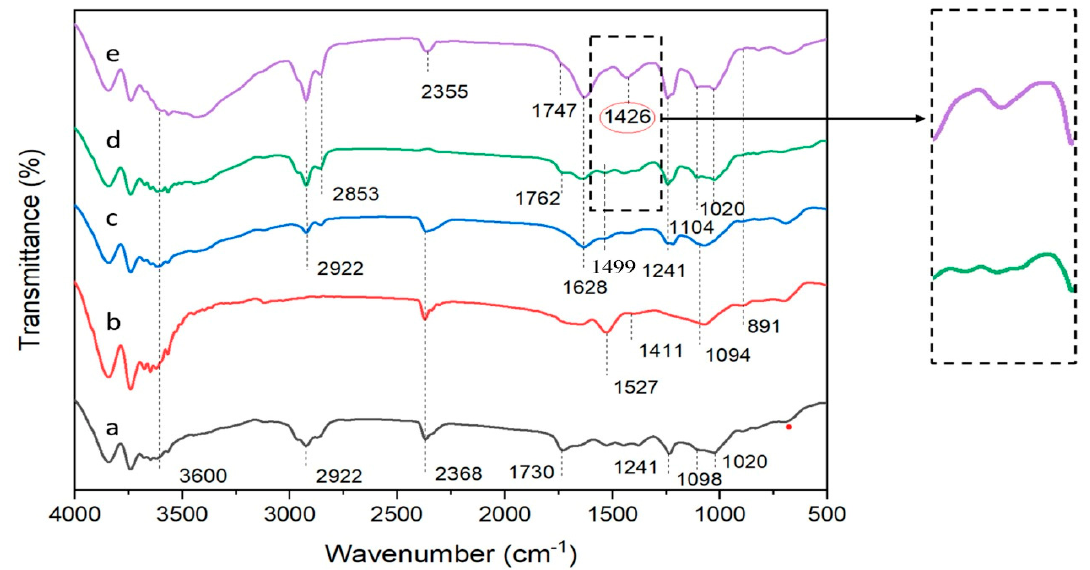
Figure 3. FTIR spectra for: ( a ) citronella oil; ( b ) Alg/Carr; ( c ) Alg/Carr/SDS; ( d ) Alg/Carr/SDS/citronella oil (non-UTS); and ( e ) Alg/Carr/SDS/citronella oil (UTS).